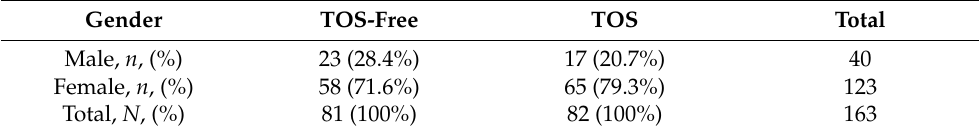
Table 1. Sample characteristics by group (TOS/TOS-free) and gender.